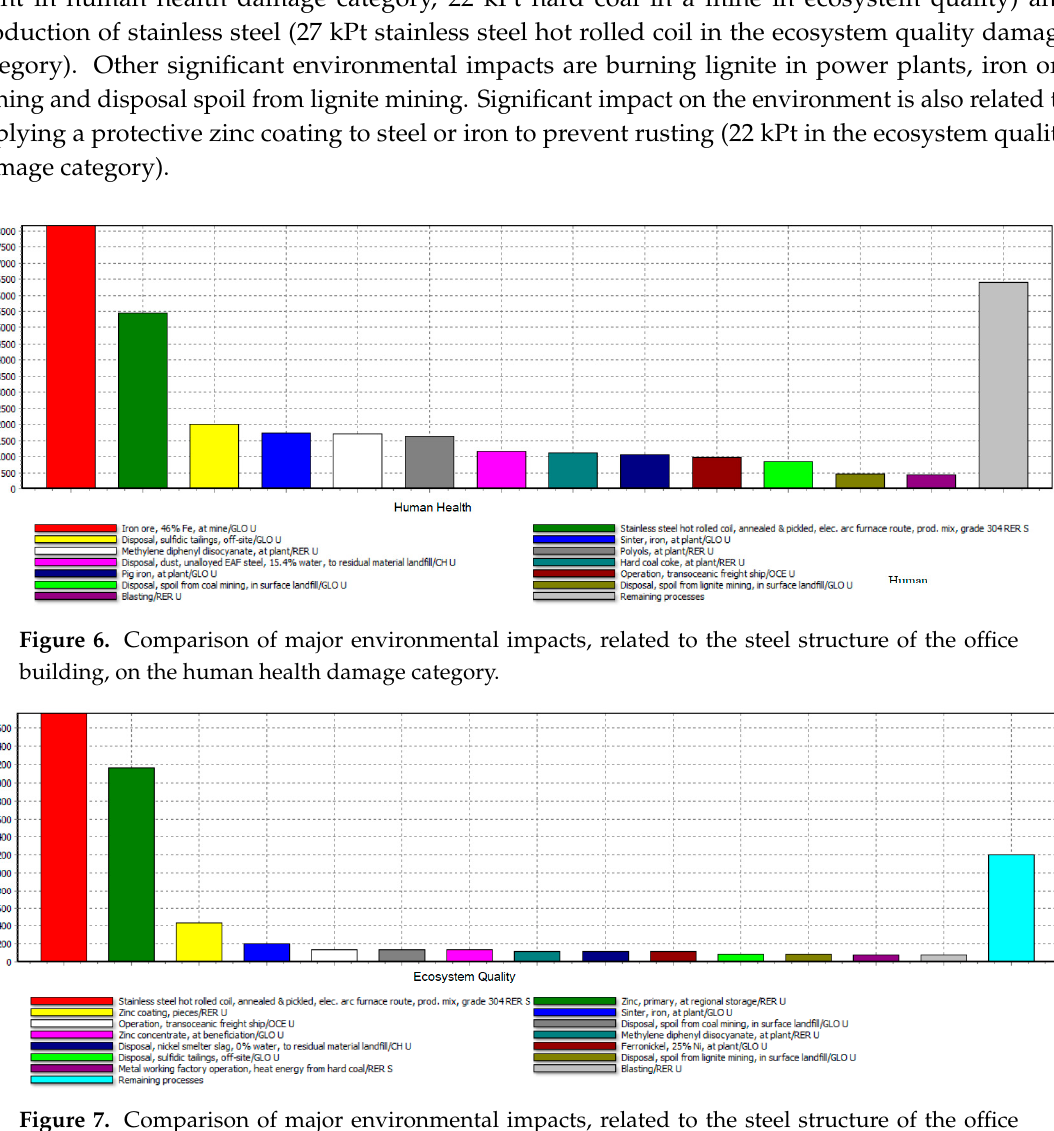
Figure 5. Weighting comparison of the environmental impact categories related to the main parts of the steelwork.